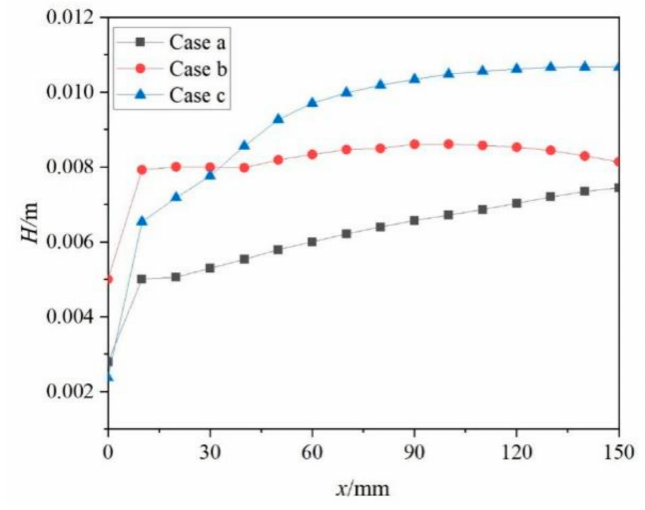
Figure 17. Penetration depth curves for Case a, Case b, and Case c.